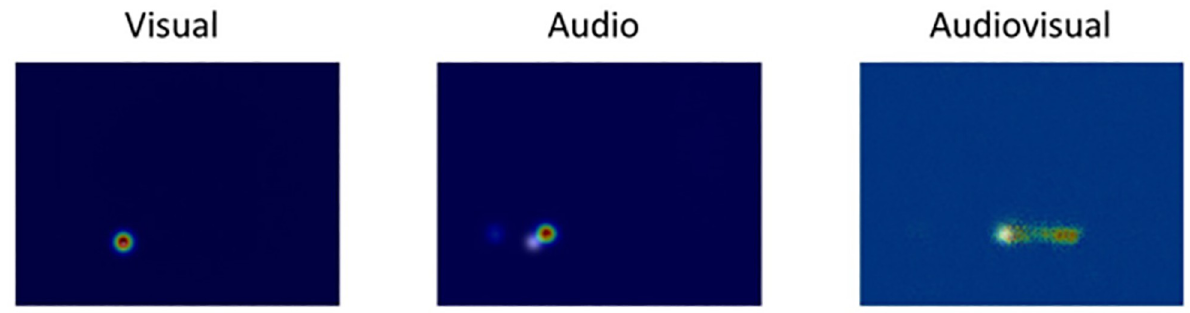
Fig 3. 2D Localization maps obtained as output, respectively from visual, auditory, and audio-visual U-net. The corresponding stimulus is predicted to the basis of the corresponding input of the model.